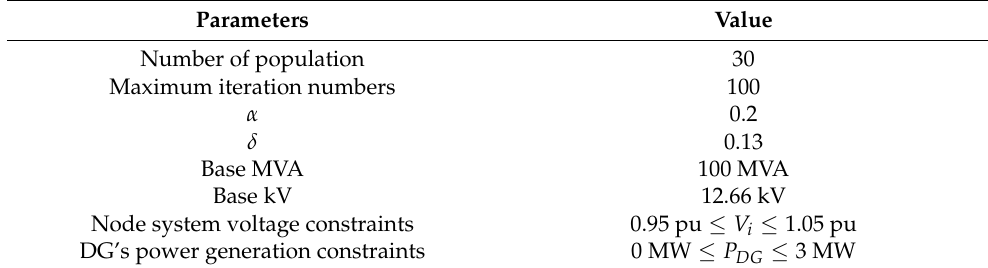
Table 12. The algorithm parameters and operative restrictions.